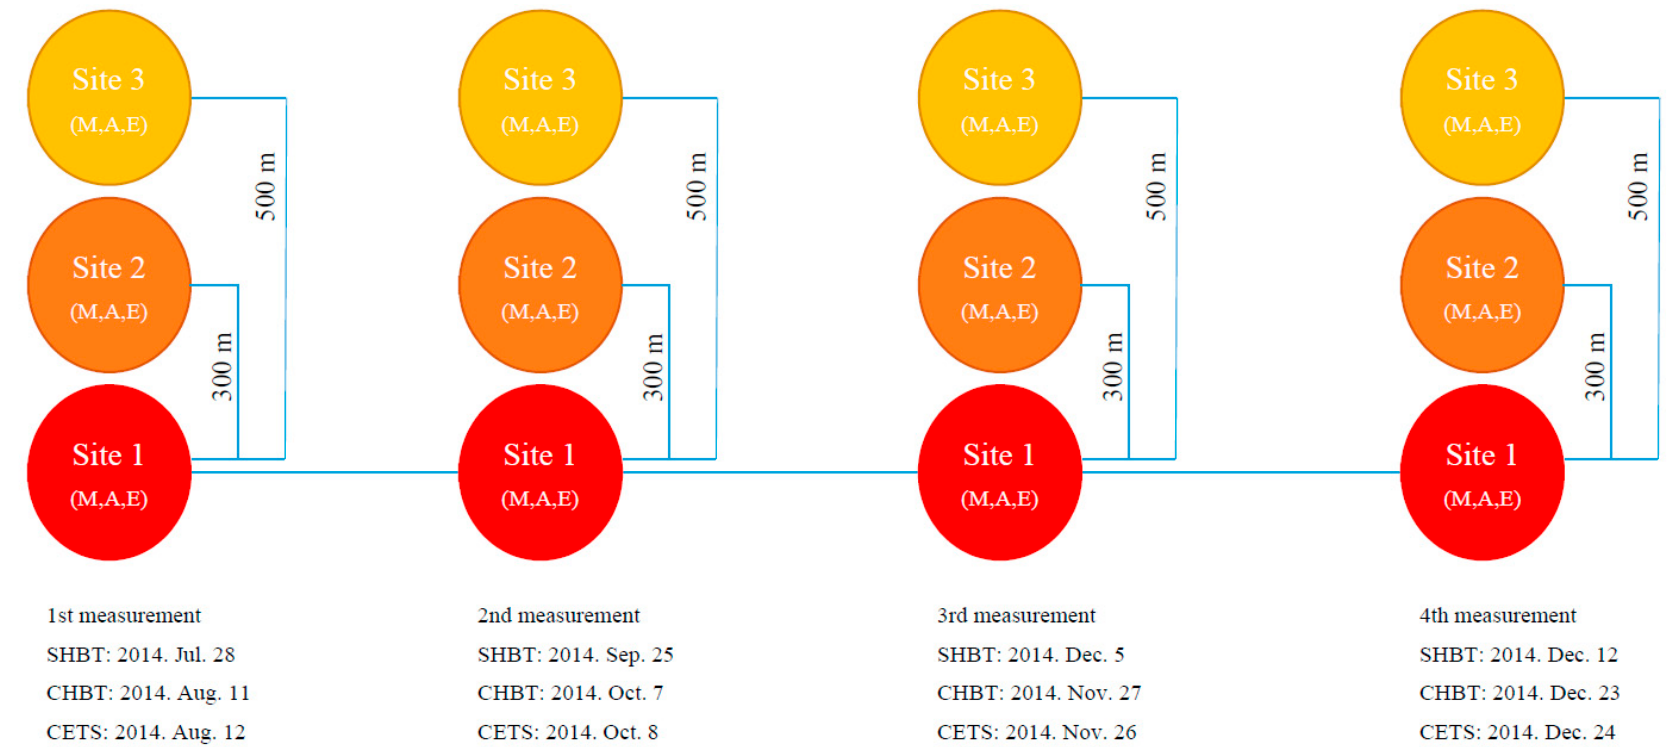
Figure 1. Sampling design applied for simultaneous PM 2.5 and BC measurement at three different diesel transportation hotspots and their adjacent residential areas (300 m or 500 m away from its hotspot) selected in South Korea. SHBT: Seoul Highway Bus Terminal, CHBT: Cheonan Highway Bus Terminal, and CETS: Cheoanasan Express Train Station; M: Morning ( n = 120 per day and Site), A: Afternoon ( n = 120), E: Evening ( n = 120).